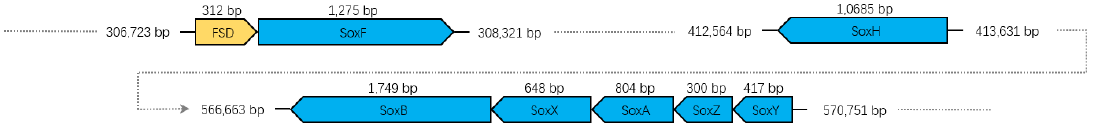
Figure 6. Sulfur oxidation gene cluster of strain CHu59-6-5 T . Color key: golden, FSD gene (cytochrome c subunit of flavocytochrome c sulfide dehydrogenase); blue; sox genes.